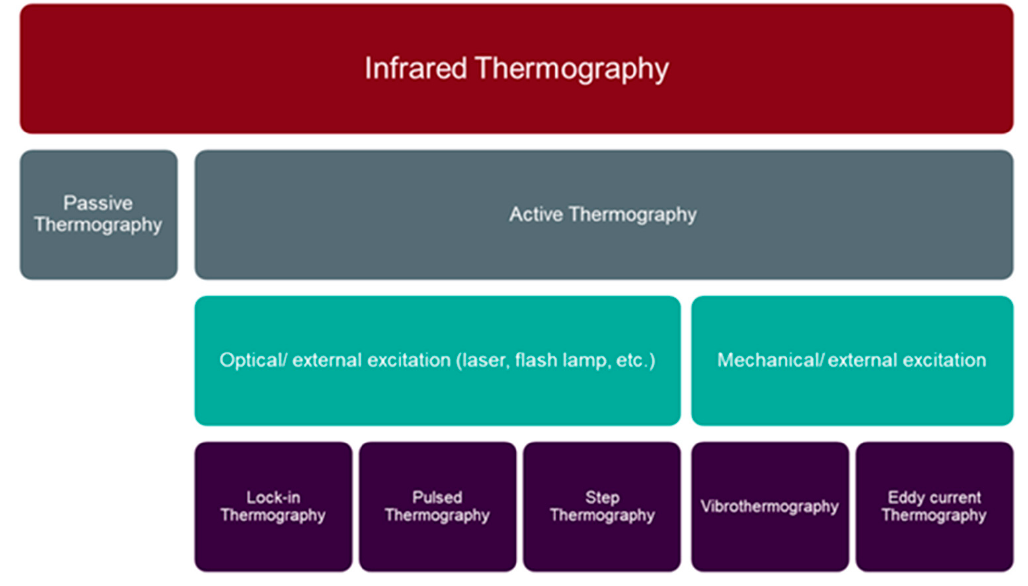
Figure 14. Thermography NDT techniques [105,106].